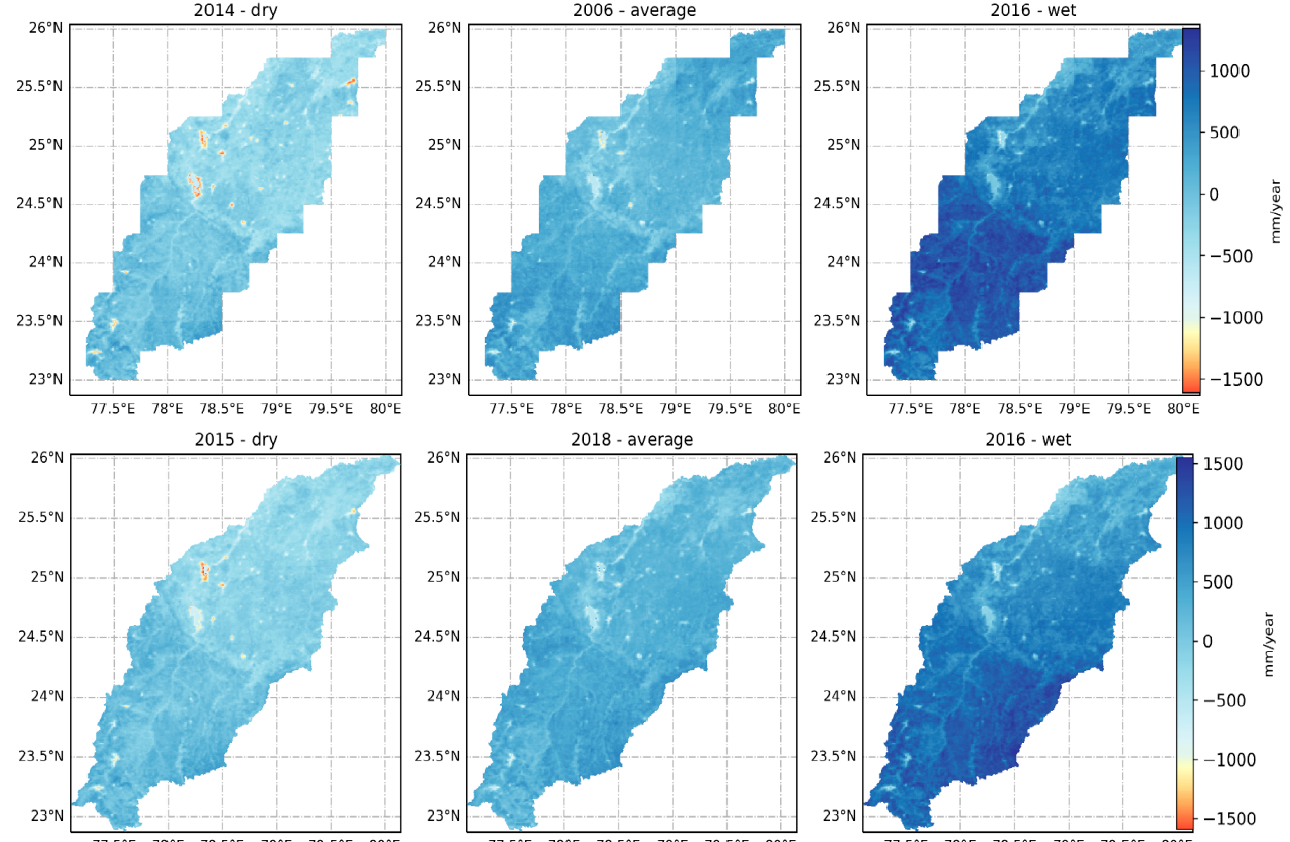
Figure 11. The figures depict yearly average water yields in the basin for dry, wet, and average years, based on PERSIANN and CHIRPS precipitation datasets.